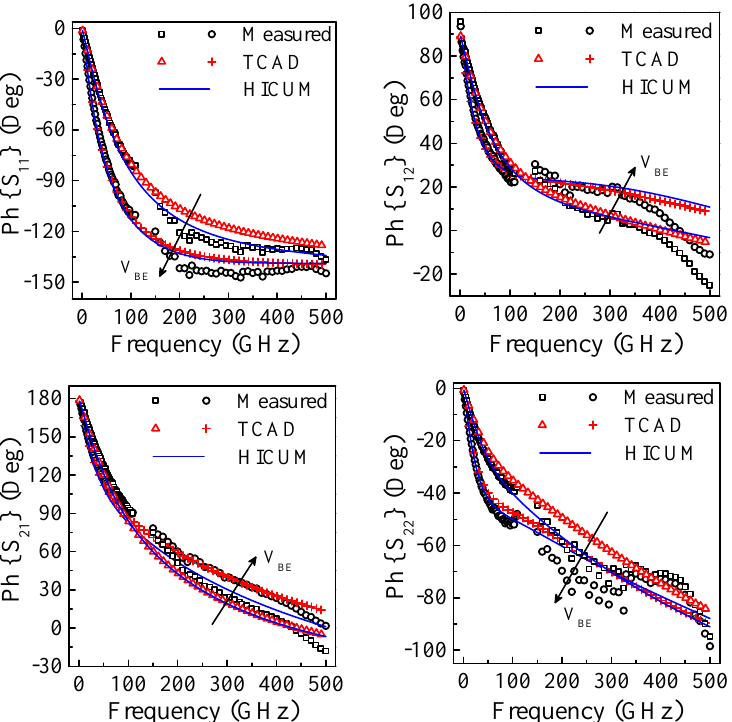
Figure 19. Frequency dependent phase of scattering parameters for the 0.09 µ m × 4.8 µ m SiGe HBT biased at V BC = 0 V with V BE = 0.8 V and 0.85 V: comparison between measured data (rectangles and circles), TCAD (triangle and cross) and HICUM (solid